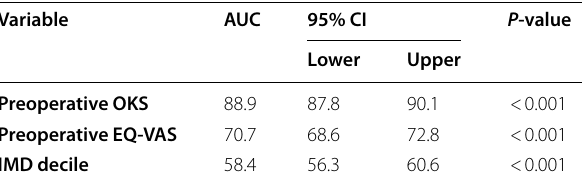
Table 3 Receiver operating characteristic curve analysis for predicting a health status WTD in patients awaiting a total knee arthroplasty according to their OKS, EQ-VAS and index of